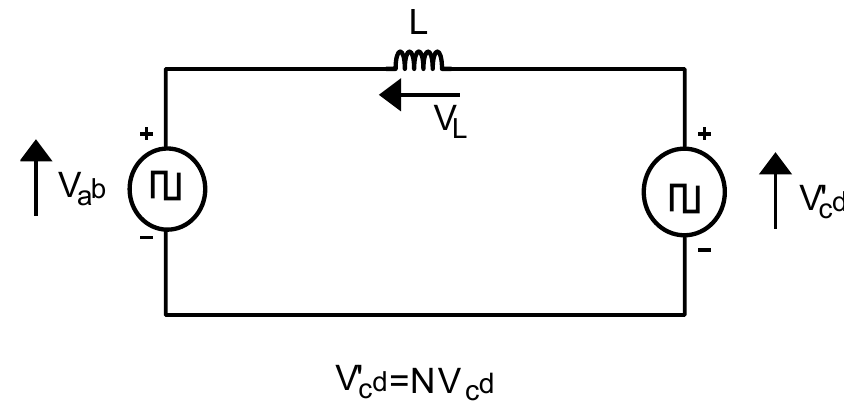
Figure 2. Simplified equivalent circuit of DAB DC-DC converter.